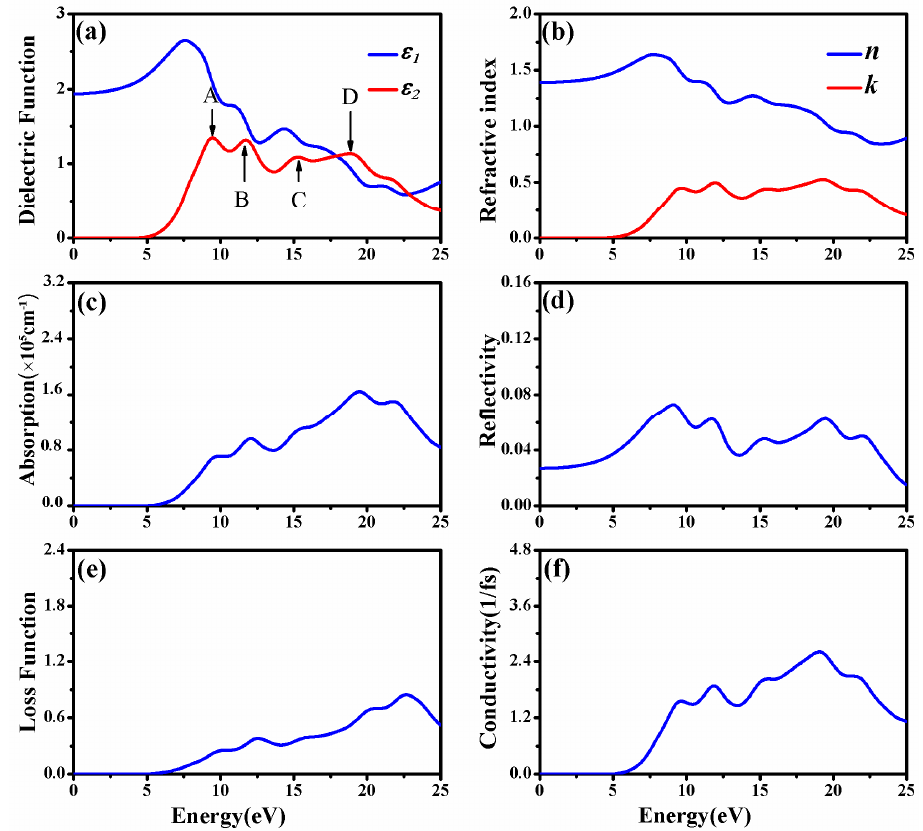
Figure 4. Optical properties of CAO: ( a ) Dielectric function; ( b ) refractive index, extinction coefficient; ( c ) absorption coefficient; ( d ) reflectivity; ( e ) loss function; and ( f ) conductivity.